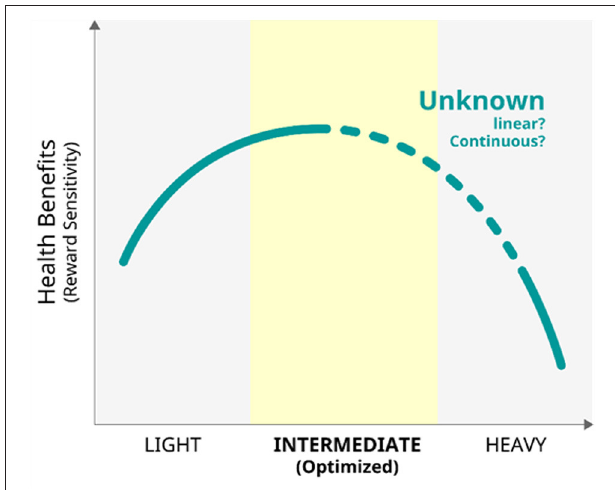
FIGURE 11 | The model of the relationship between habitual behaviours and health benefits of the reward